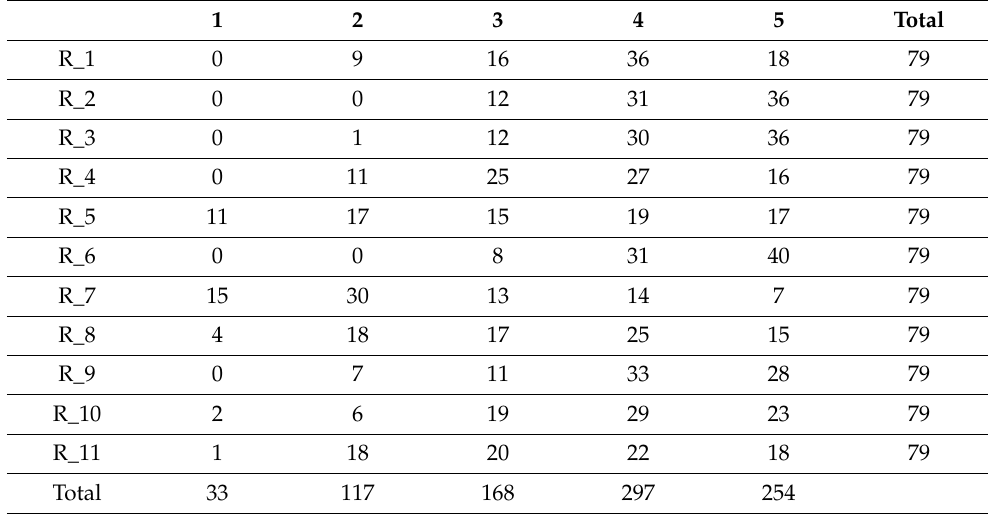
Figure 1. Assessments of the influence of realized SM projects on business operations. Source: own research [73].